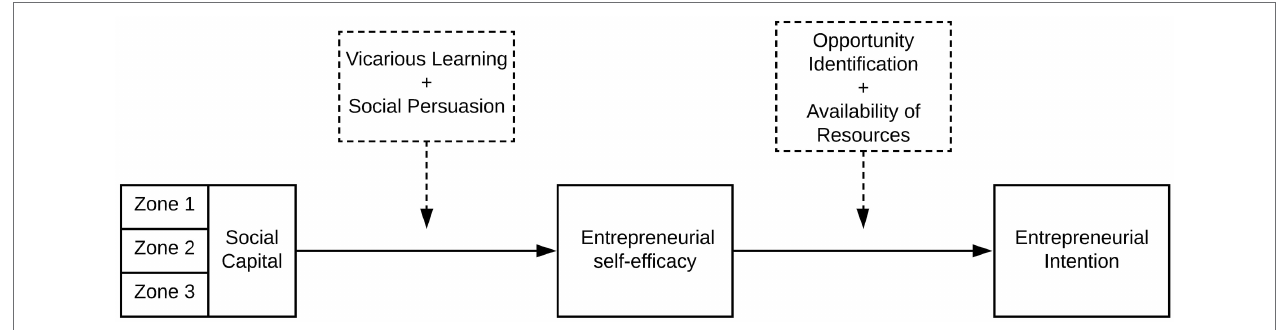
FIGURE 1 | Antecedents of entrepreneurial